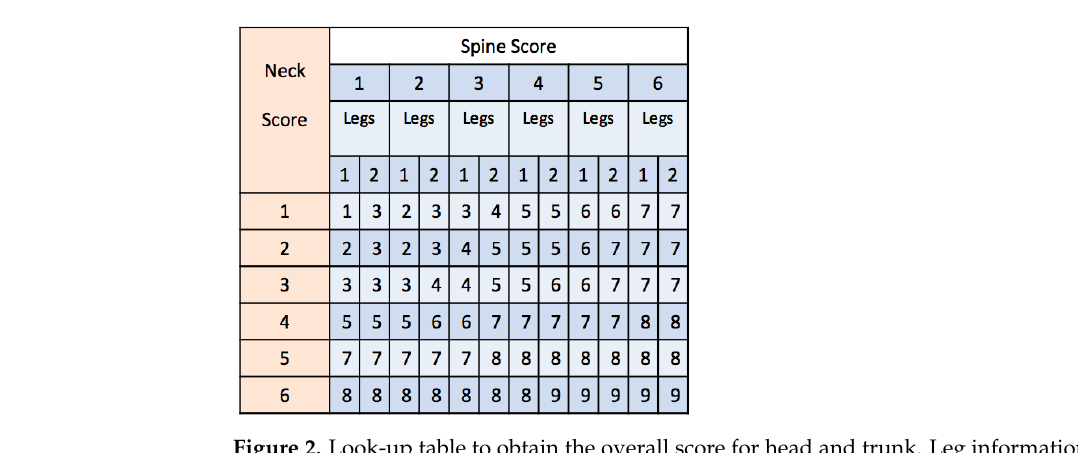
Figure 2. Look-up table to obtain the overall score for head and trunk. Leg information was entered as a constant (value equal to 1), given the specific scenario of this